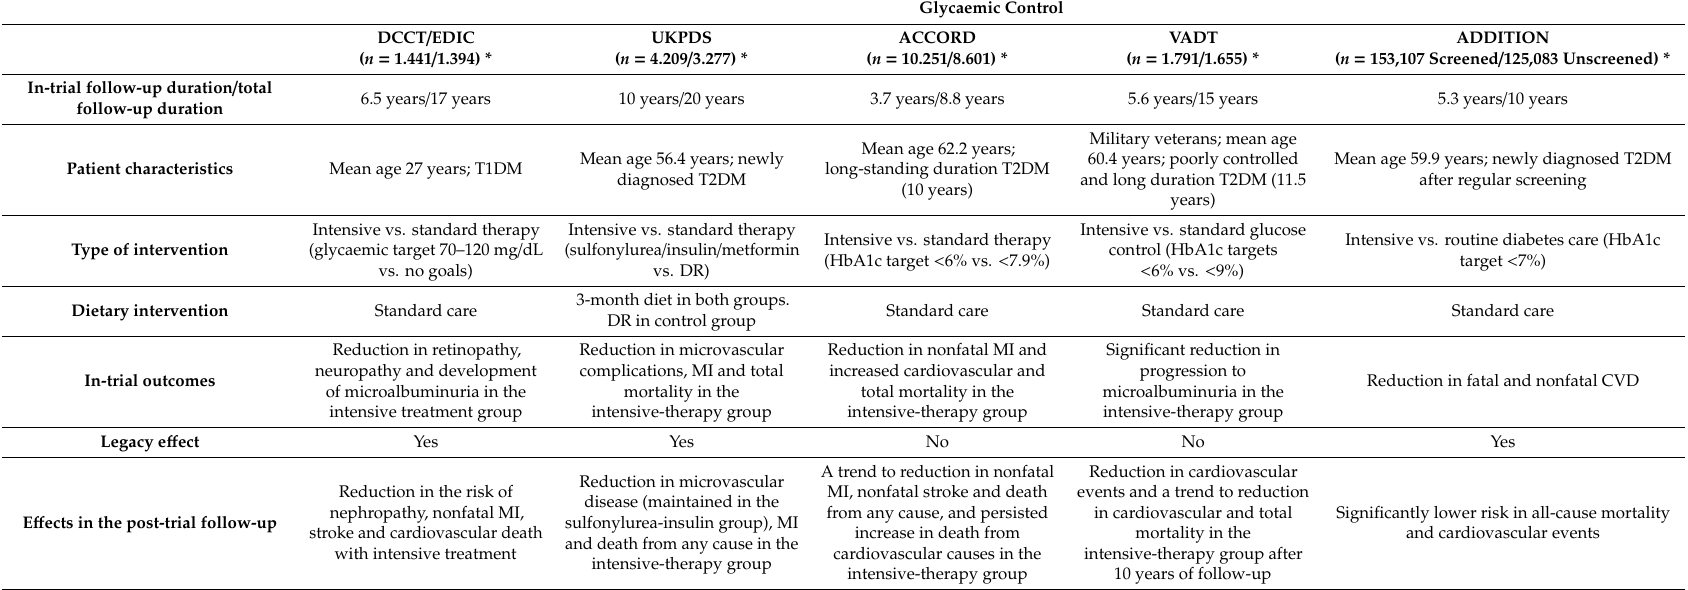
Table 1. Studies assessing the legacy e ff ect after intensive glycaemic